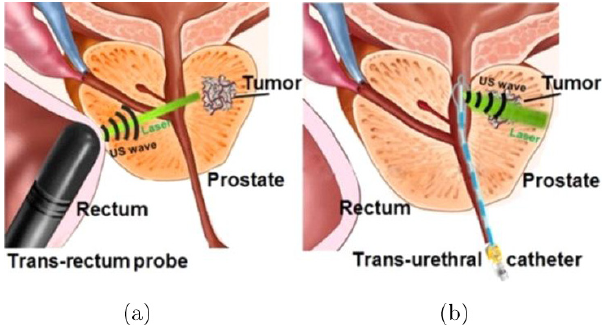
Fig. 1. Con¯gurations of transrectal (a) and transurethral (b) PAI of the prostate. (a) A transrectal US transducer coupled with transrectal light delivery; (b) A transurethral US transducer coupled with transurethral light